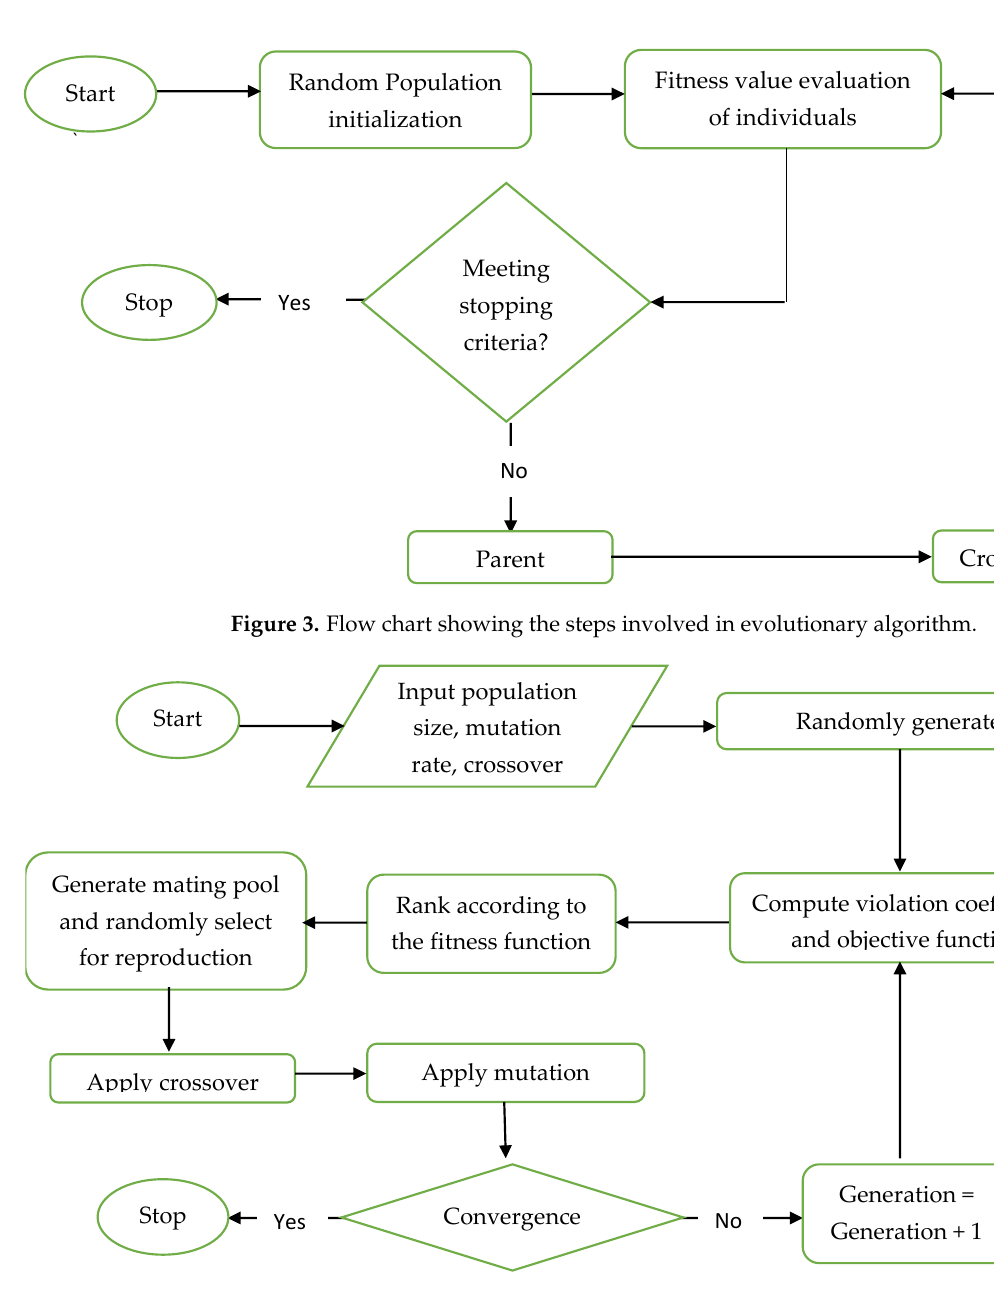
Figure 4. Flowchart showing the steps involved in the Genetic Algorithm.